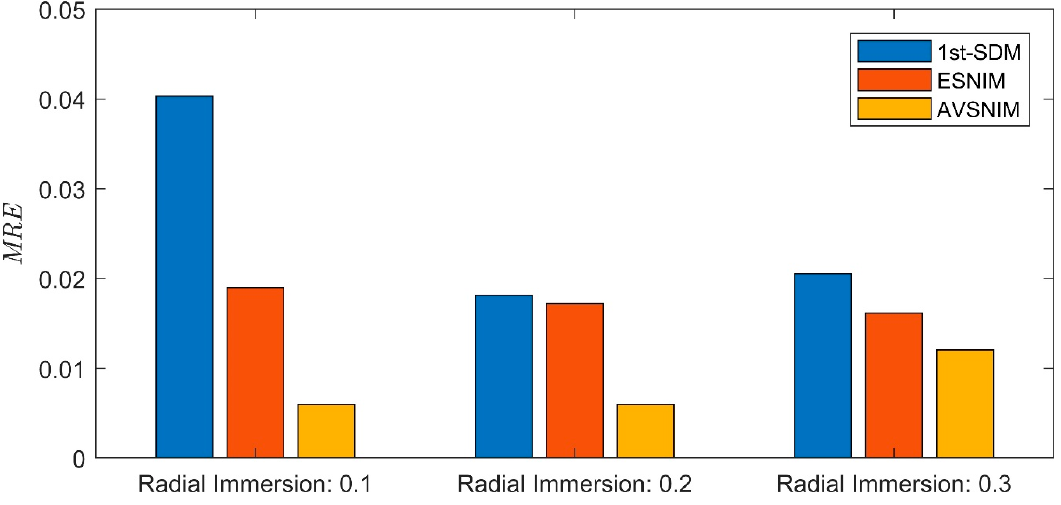
Figure 7. Mean relative error of stability limit obtained by 1st-SDM, ESNIM and AVSNIM.